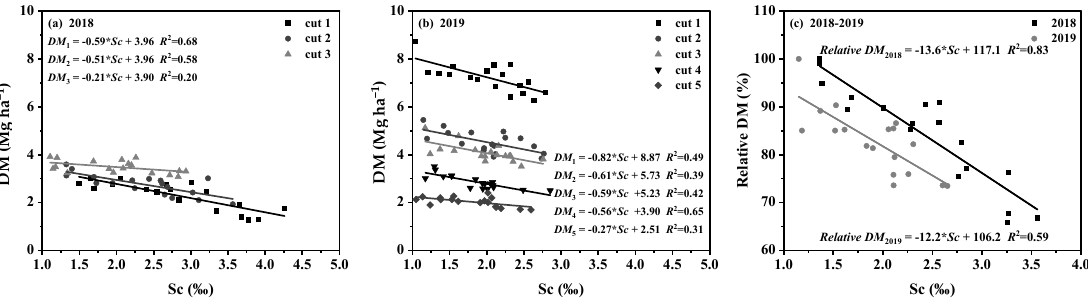
Figure 4. Linear regression between dry matter (DM) of each cut with the average soil salt content during the respective cut period for 2018 ( a ) and 2019 ( b ) and between the relative total yield with the average soil salt content during the whole growing period in 2018 and 2019 ( c